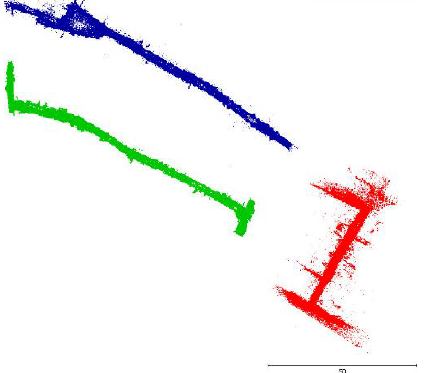
Figure 9: A top view of the 3 documented areas